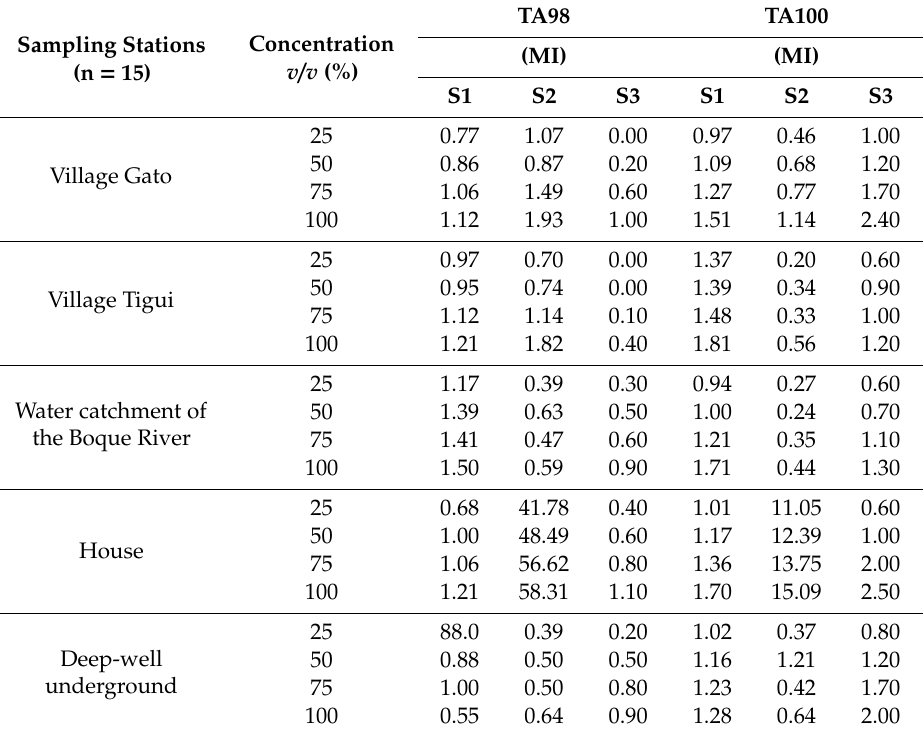
Table 3. Mutagenic index, for each concentration analyzed in the five sampling stations with strain Salmonella typhimurium TA98 and S. typhimurium